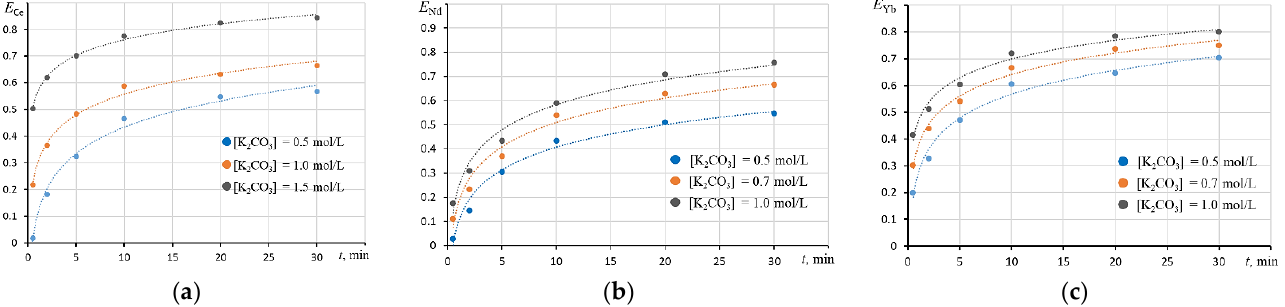
Figure 2. The extent to which lanthanides are recovered depends on the concentration of potassium carbonate: ( a ) for Ce; ( b ) for Nd; ( c ) for Yb. Table 4. Empirical dependence of the degree of recovery into the solution on the concentration of potassium carbonate.